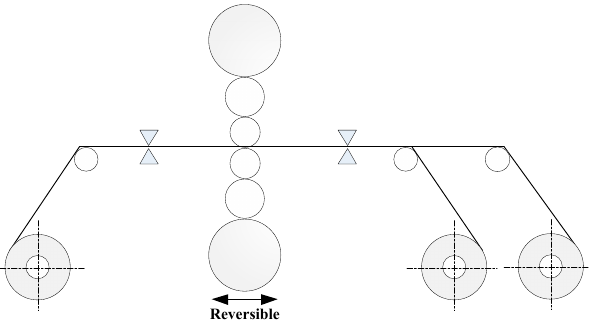
Figure 1. Rolling diagram of six-high reversing cold mill.